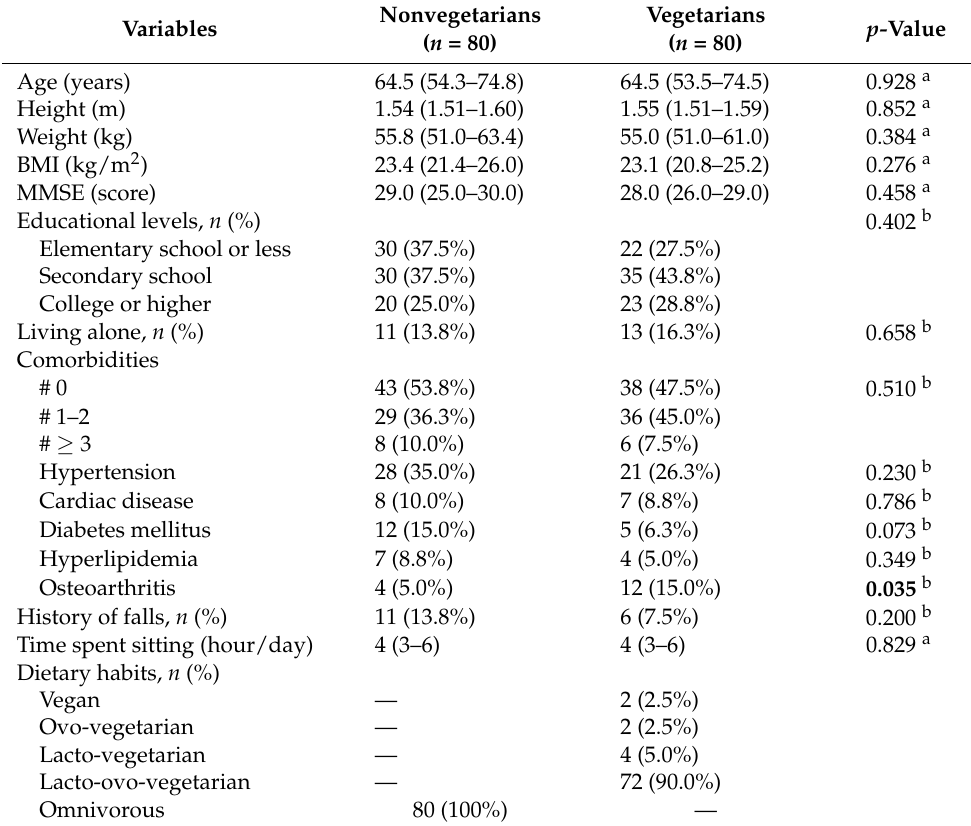
Table 1. Participant characteristics ( n =